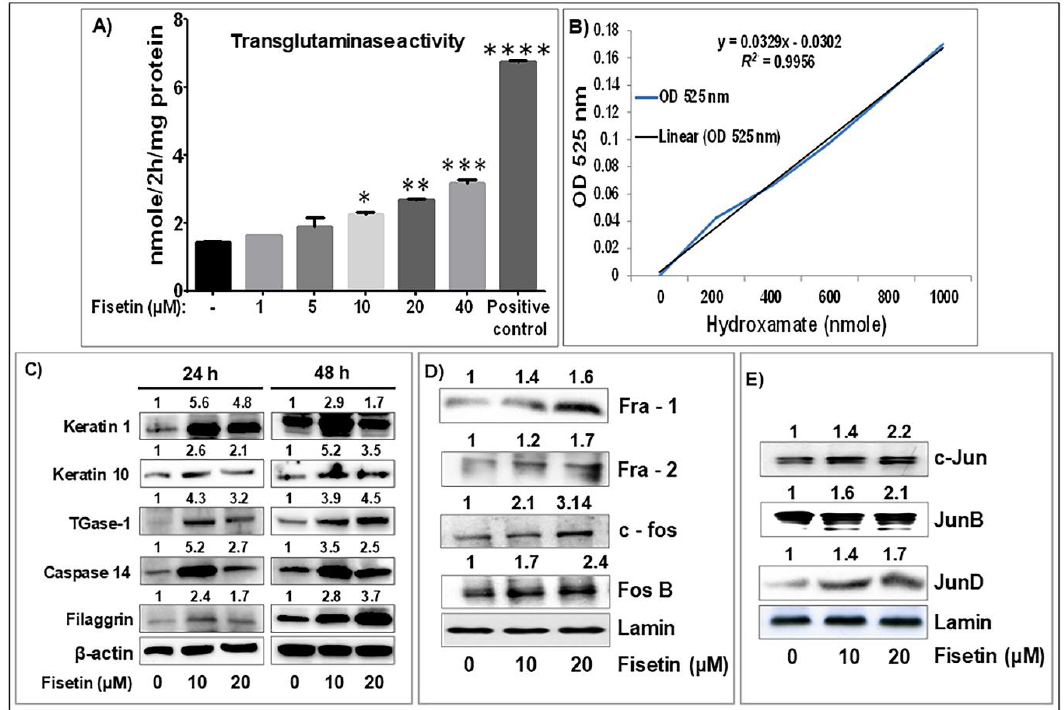
Figure 2. Fisetin treatment increased the expression of markers of epidermal keratinocytes’ differentiation and AP-1 transcription factor in NHEK. ( A , B ) The bar graphs represent dose-dependent induction of the differentiation marker transglutaminase (TGase) (a terminal differentiation marker) activity in NHEK treated with or without different doses of fisetin for 24 h, and the linear plot of the hydroxamate analysis of TGase activity. Data represent means ± SEM of three independent experiments, each performed in quadruplicate. Significance was assessed for control cells versus fisetin-treated cells or positive control, determined by one-way analysis of variance, as denoted by * p < 0.05, ** p < 0.01, *** p < 0.001, and **** p < 0.0001. Dose- and time-dependent increases in the protein expression of ( C ) early and late differentiation markers, and ( D , E ) nuclear protein expression of members of AP-1 factors subunits including Jun (C-Jun, Jun B, Jun D) and Fos (C-Fos, Fra-2, Fos-B) in NHEKs when compared to control cultures after 48 h, as analyzed by Western blotting. Panels ( C – E ) are representative of 2 – 3 experiments with similar results. Equal protein loading was confirmed using β -actin and lamin as loading controls, and the numerical data above the blots represent the quantitative relative densitometry values for the blots normalized to their respective loading controls.